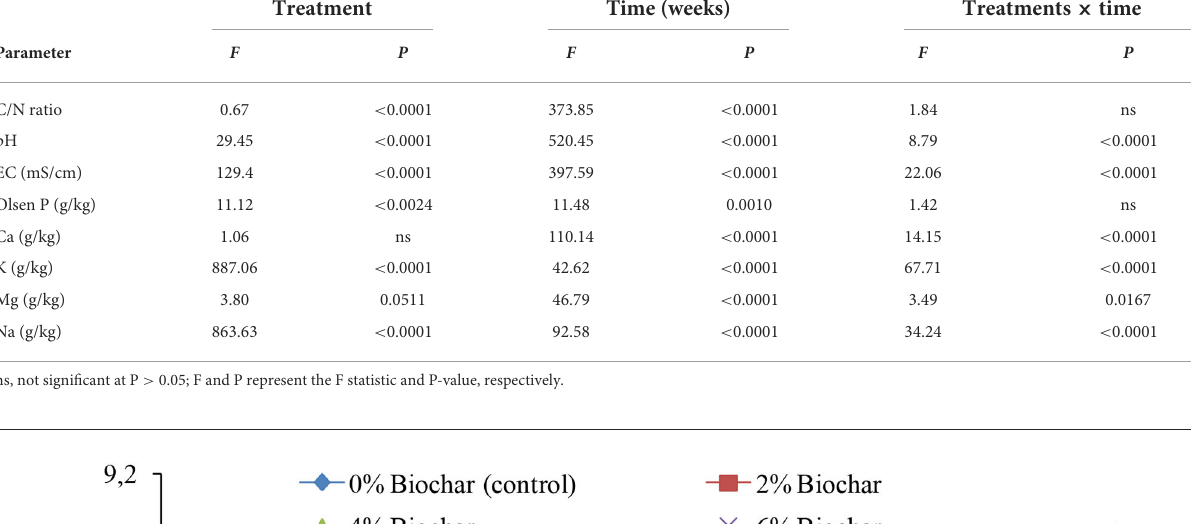
TABLE 1 Repeated measures of ANOVA for changes in the selected parameters during vermicomposting of a goat manure–food waste mixture amended with seaweed ( G. funicularis ) biochar. Treatment Time (weeks) Treatments ×